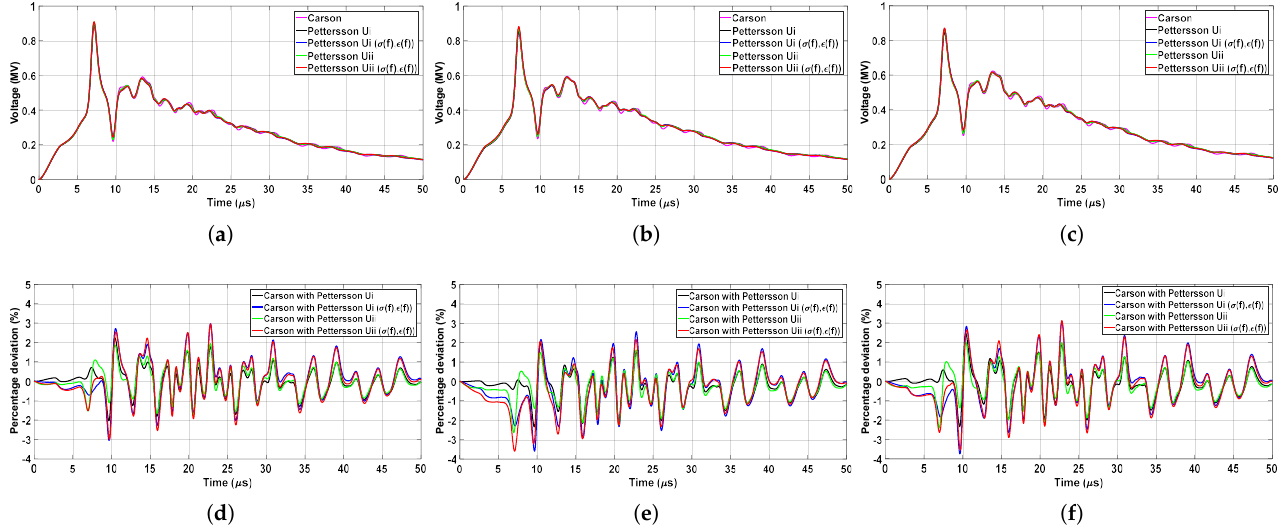
Figure 13. Overvoltage waveform in phases A ( a ), B ( b ) and C ( c ) and percentage differences, based on Carson’s formulation, for phases A ( d ), B ( e ) and C ( f ), considering ground resistivity equal to 3000 Ω .m and a lightning stroke current waveform with α = 1.66.